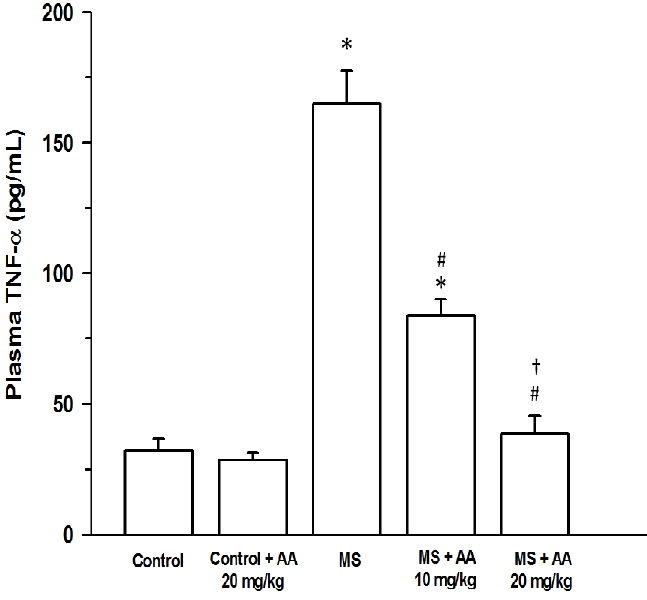
Figure 5. Effect of asiatic acid on plasma TNF- α in all experimental groups. Results are expressed as mean ± SEM. AA represents asiatic acid. * p < 0.05 vs . control group, # p < 0.05 vs . MS group, † p < 0.05 vs . MS + AA 10 mg/kg group ( n =